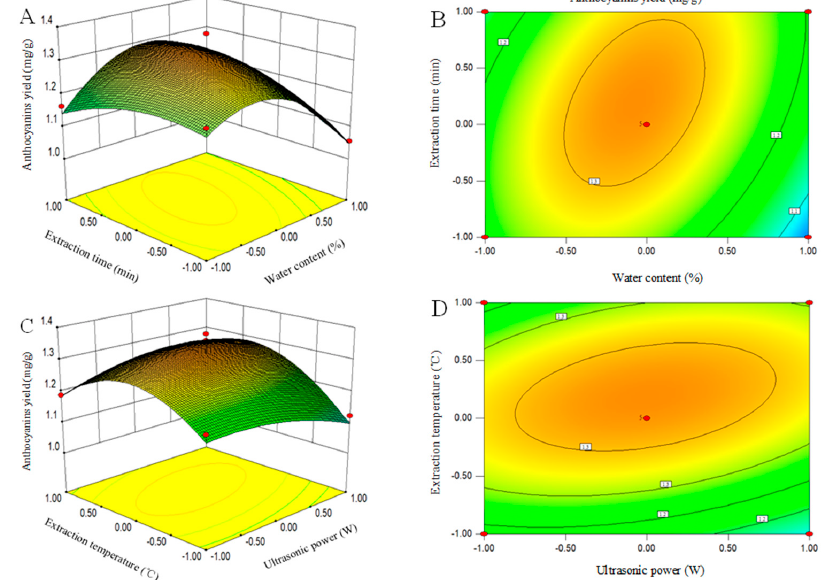
Figure 3. Three-dimensional response surface plots and corresponding contour plots. Influence of the water content and ultrasonic power ( A , B ) and ultrasonic power and extraction temperature ( C , D ) on anthocyanin yields from raspberries.